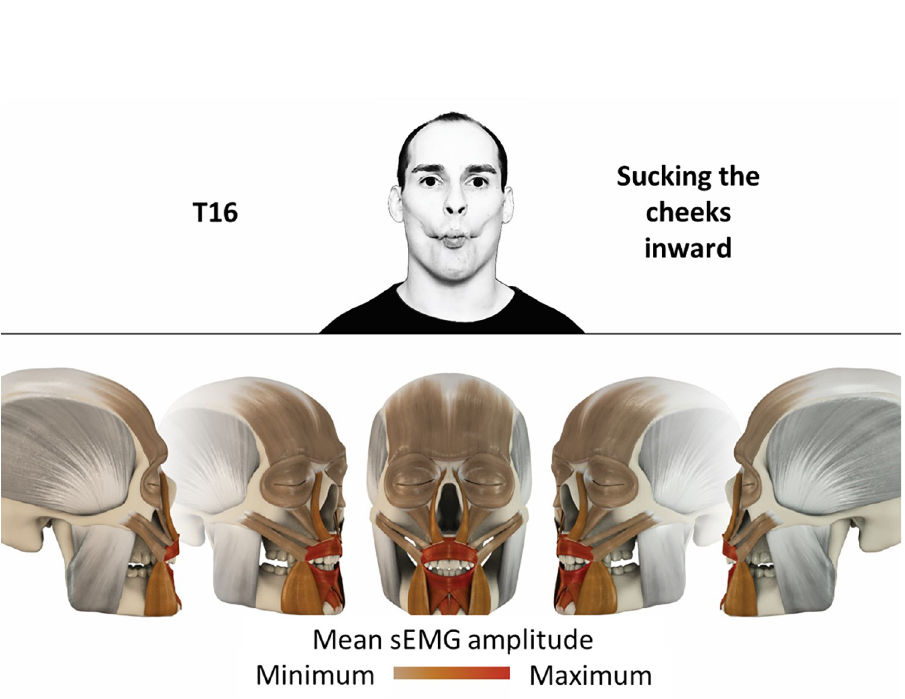
Fig 17. Color-coded facial muscle activation pattern of task T16. Sucking cheeks inward. Animation by Jonas Laustro¨er.